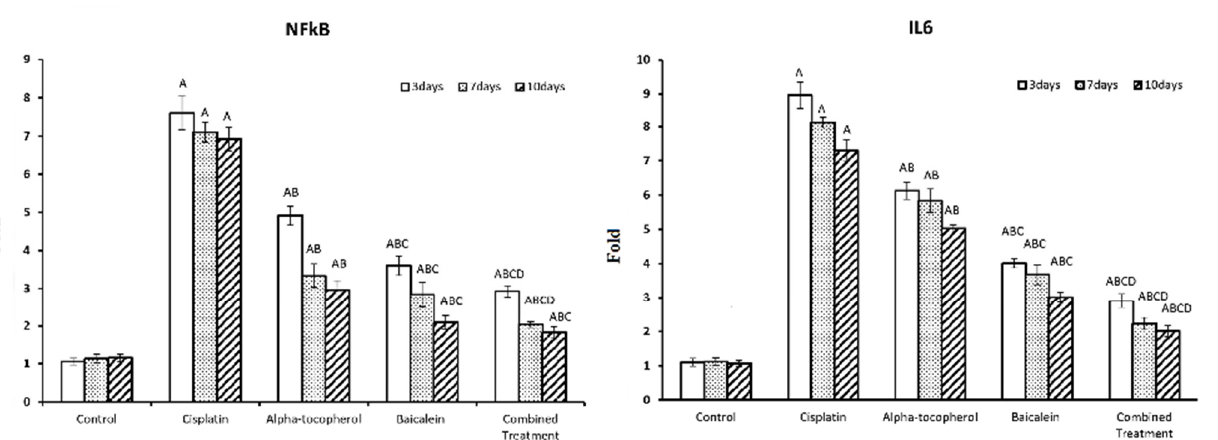
Figure 4. Effect of α -tocopherol and baicalein administration on NF- κ B, IL-6, and TNF in control and treated groups. All data are expressed as mean ± SEM. Significant vs. control group refers to A, while significant vs. (cisplatin, -tocopherol, and baicalein) treatment groups refers to (B, C, D), re- spectively. 2.4. Effect of α -Tocopherol and Baicalein Administration on TLR2 and TLR4 Genes in Control and Treated Groups TLRs are crucial in triggering immunological responses that stimulate cells and in- duce the release of proinflammatory cytokines, resulting in a greater immunoinflamma- tory response. Figure 5 shows the assessment of TLR2 and TLR4 at different periods of time (3, 7, and 10 days). TLR2 and TLR4 were significantly increased after the administra- tion of cisplatin. Upon treatment with α -tocopherol, baicalein, and combined treatment, TLR2 and TLR4 were significantly decreased in nephrotoxicity-induced groups. Baicalein showed better improving action than α -tocopherol. The combined treatment was the most effective and the nearest to the normal status.